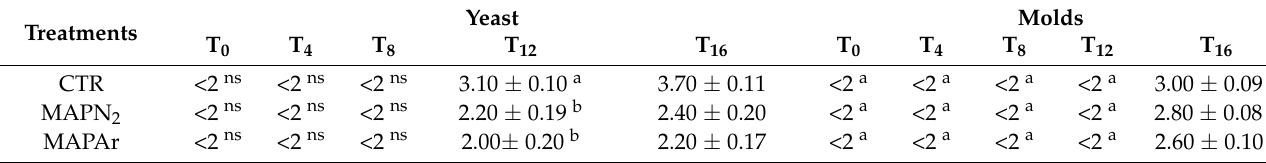
Table 6. Yeast and mold loads of fruit samples treated with MAP (CTR: 20.9% O 2 + 0.04% CO 2 (passive-MAP); MAPN 2 : ± SD. Different letters indicate statistical differences ( p ≤ 0.05) between treatments for the same storage times. Letter “a” denotes the highest value, “ns” denotes no significant difference. Values were recorded at 0 (T 0 ), 4 (T 4 ), 8 (T 8 ), 12 (T 12 ), and 16 (T 16 ) days at 4 ± 1 ◦ C and 90 ± 5%